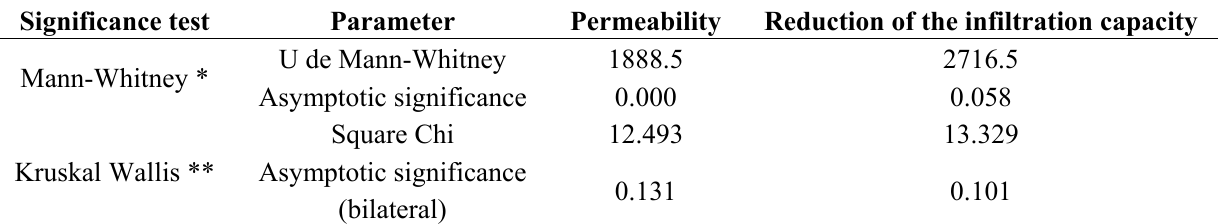
Table 4. Mann-Whitney and Kruskal Wallis significance tests for the outcome variables.